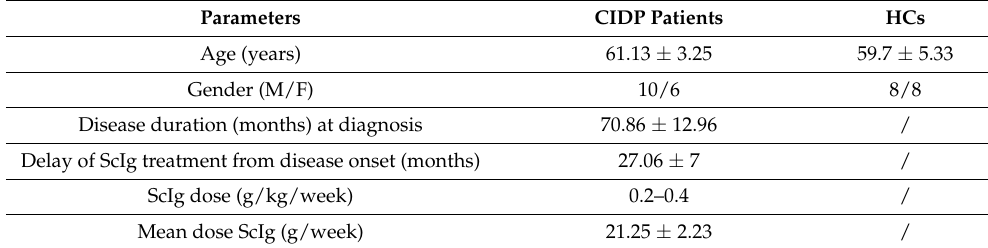
Table legend. CIDP: chronic inflammatory demyelinating polyneuropathy; HCs: healthy controls; ScIg: subcuta- neous immunoglobulin; EMG: electromyography. Table 2. Clinical parameters at baseline (before treatment), after one cycle of IVIg and after ScIg for 24 months.